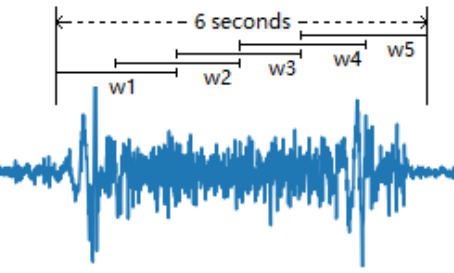
Figure 7. sEMG signal segment divided into a series of overlapping analysis